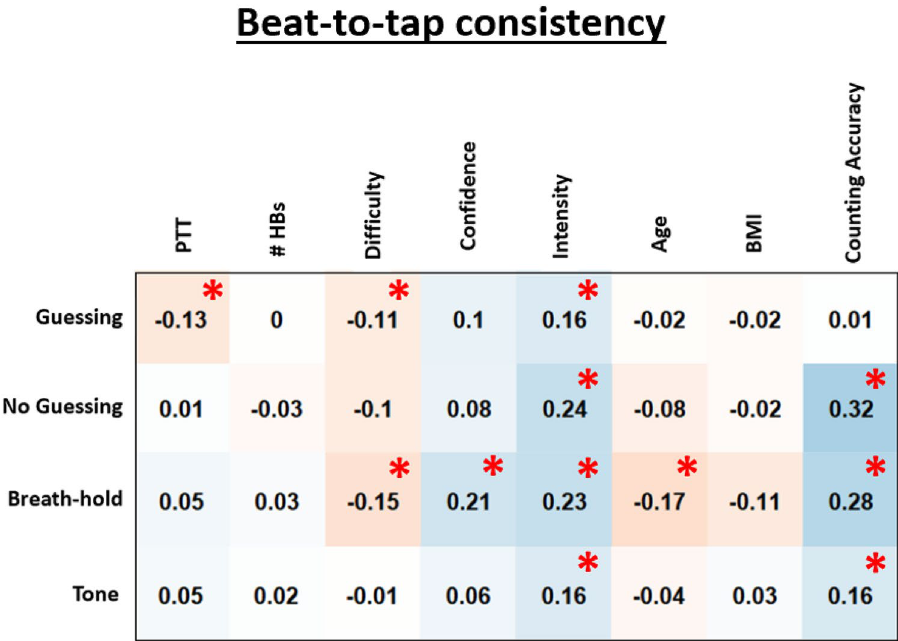
Figure 2. Exploratory Pearson correlations between beat-to-tap consistency by condition (rows), interoceptive accuracy via the standard heartbeat counting formula (counting accuracy), and other self-report and task- relevant variables across task conditions. PTT median pulse transit time, #HBs number of heartbeats during the task condition, BMI body mass index. For reference, significant correlations at p < 0.05 (uncorrected) are marked with red